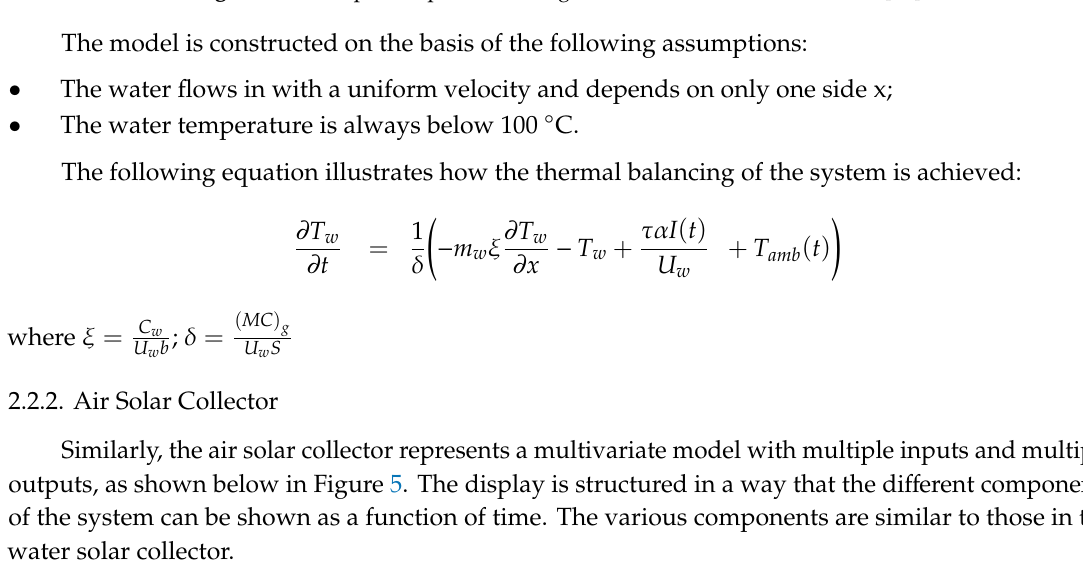
Figure 4. The input/output block diagram of the water solar collector [18].